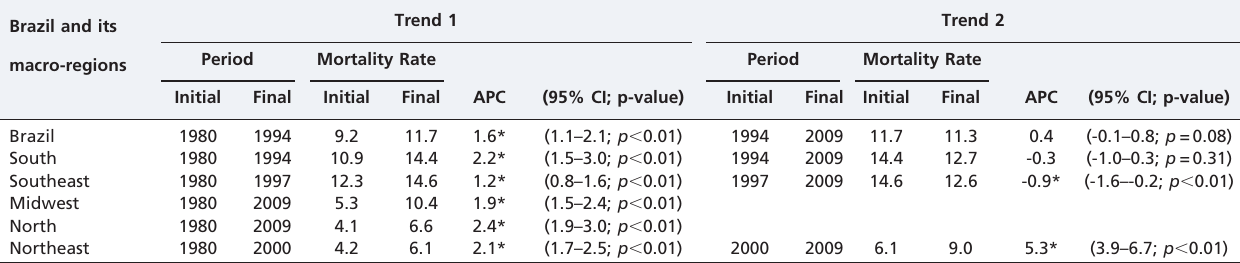
Table 1 - Female breast cancer mortality trends between 1980 and 2009 in Brazil and the macro-regions of the country. Brazil and its Trend 1 macro-regions